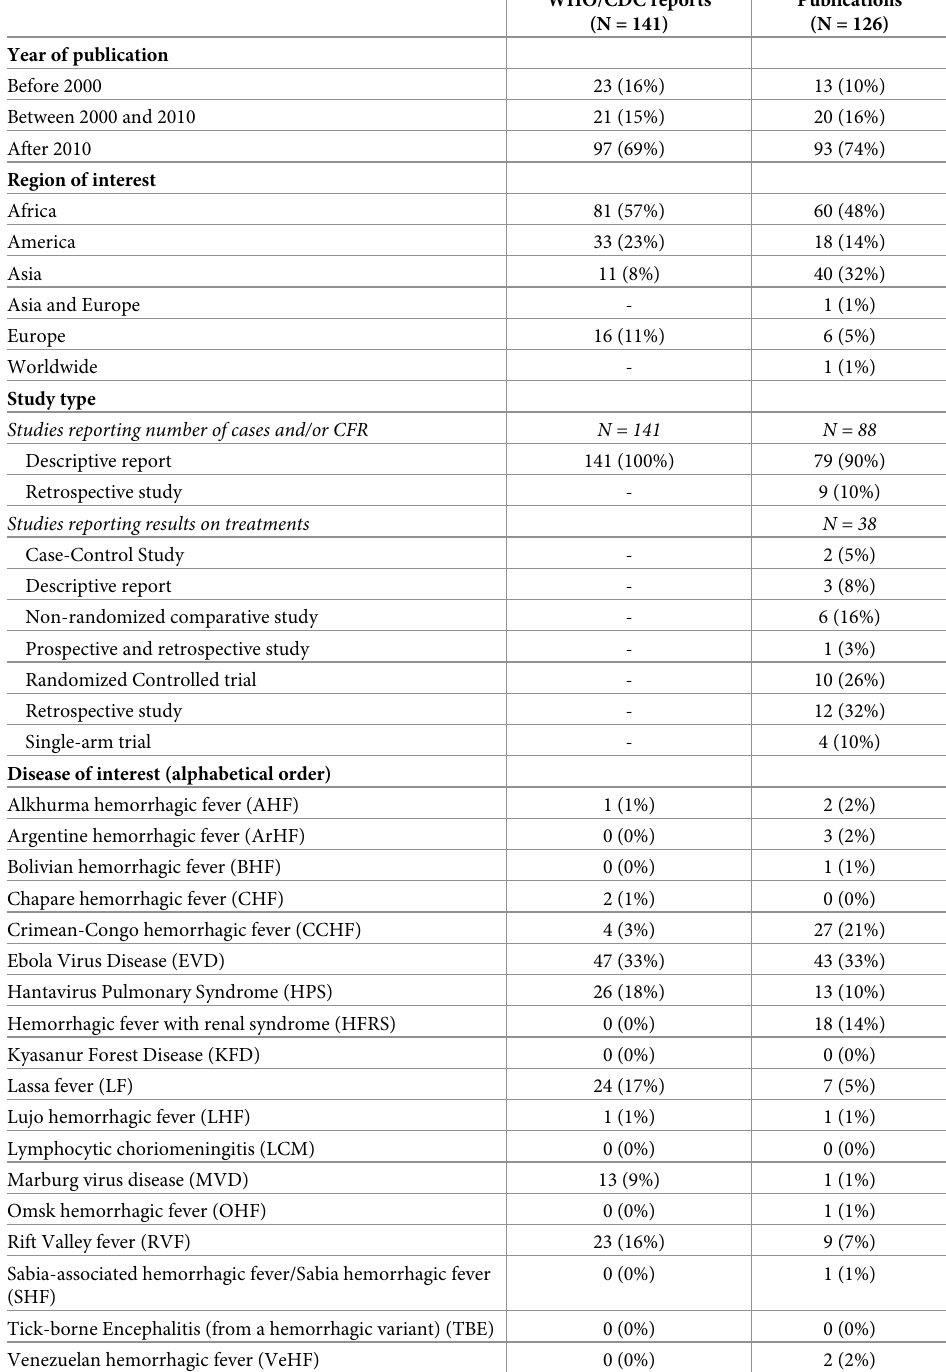
Table 1. Characteristics of included